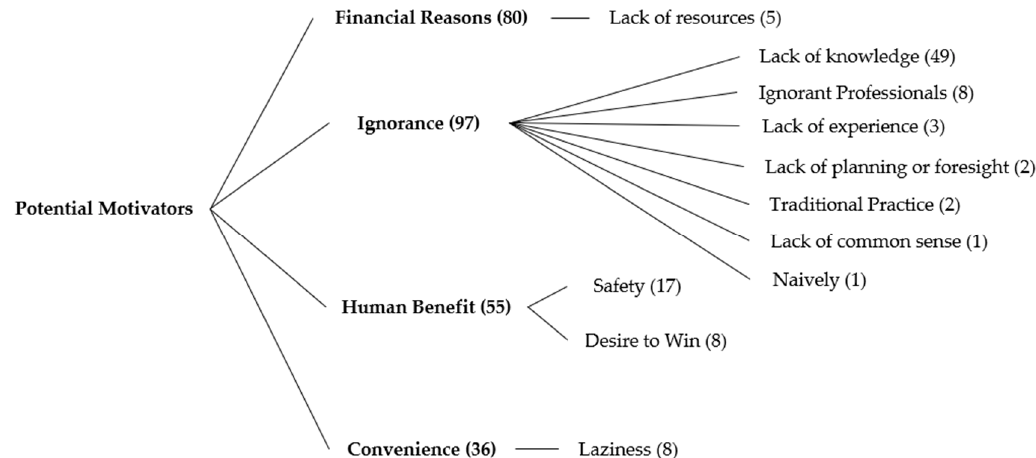
Figure 2. Taxonomic tree diagram of the four highest referenced potential motivators behind the welfare concerns identified in 12 vignettes by respondents ( n = 14). Numbers in brackets indicate number of references for each category.